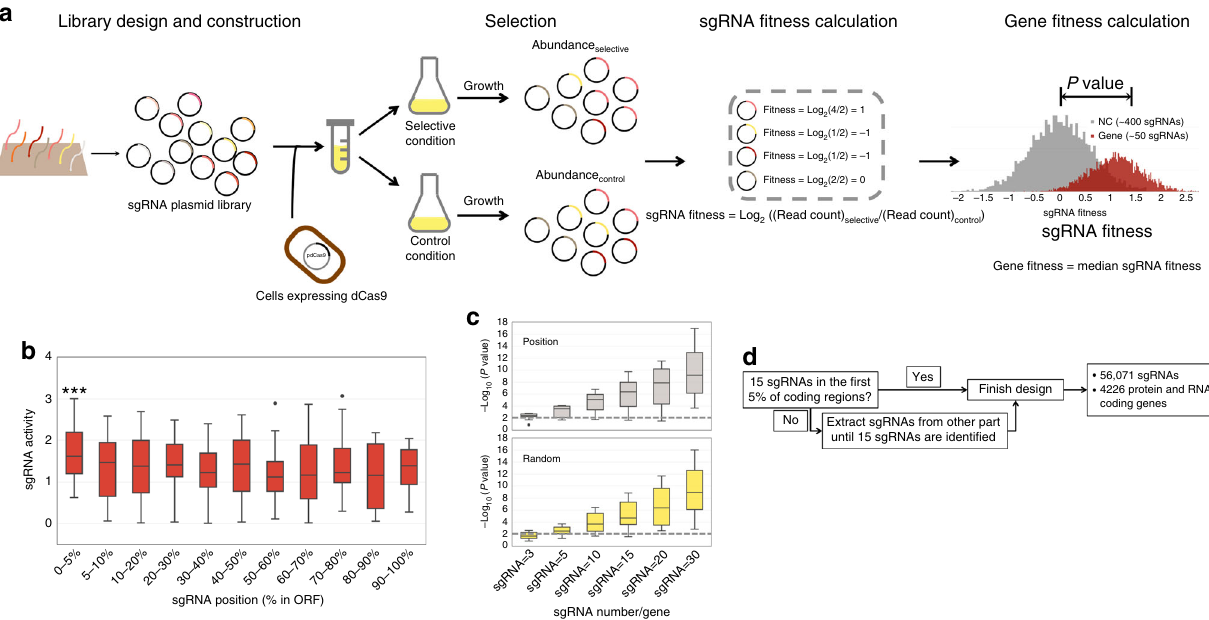
Fig. 1 Overview of this work. a Proof-of-concept demonstration of the CRISPRi pooled screening for high-throughput functional genomics in E. coli . An sgRNA library targeting genes of interest is synthesized on a DNA microarray. Oligonucleotides are ampli fi ed and cloned into expression plasmids, transformed into E. coli expressing dCas9 protein, resulting in cell libraries. The cell libraries are grown under selective and control conditions. NGS libraries are constructed based on the extracted plasmids to determine the log 2 change of each sgRNA between the selective and control conditions (sgRNA fi tness). The sgRNA fi tness distribution (red histogram) of each gene is compared with that of control sgRNAs (no target site in the E. coli genome; gray histogram) to evaluate the extent to which this gene is associated with relevant phenotypes (selective conditions). In the fi rst part of this work, we designed a tiling sgRNA library composed of 2281 members targeting 44 genes with known phenotypes to evaluate the activities of these sgRNAs. b The absolute values of the Z scores for each sgRNA targeting the true positive genes were extracted, and the distribution of each group (categorized via position in the ORFs) against all 468 sgRNAs was quanti fi ed by a two-tailed MWU test. Triple asterisks indicate P < 0.01. For clarity, only sgRNAs with absolute Z scores of 0 – 4 were plotted. c The minimal number of sgRNAs per gene for reliable hit-gene calling. Results are shown for sampling of 3, 5, 10, 15, 20, and 30 sgRNAs for each gene (16 true positive genes in Library I). Two algorithms (position (Supplementary Fig. 4, see Methods) and random) were applied to determine the priority of sgRNA selection during sampling. Results are presented as box plots of the − Log 10 ( P value) (MWU test) for the genes recalculated with the sampled sgRNA subset. Dashed line refers to P = 0.01. d In the second part of this work, we designed a genome-scale